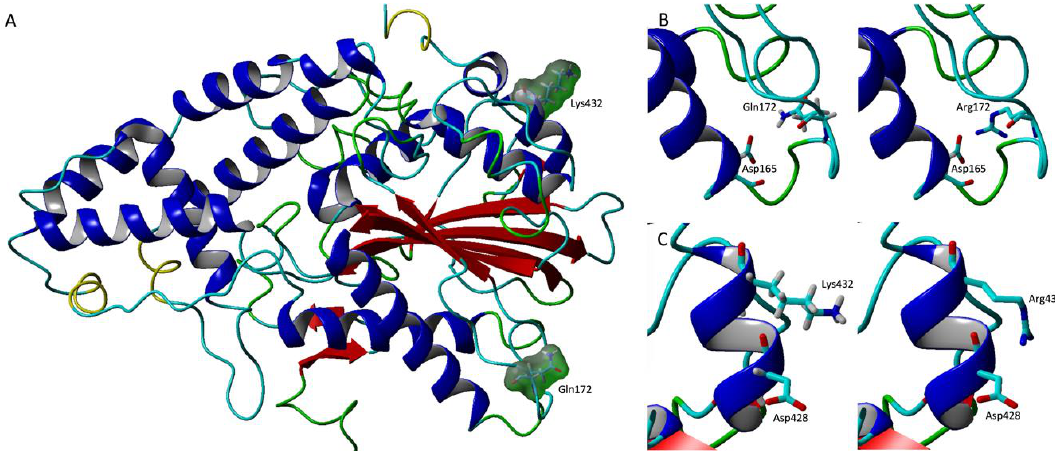
Figure 5. Site-directed mutagenesis on Aspergillus niger N25 phytase. ( A ) Mutation sites of Q172 and K432. ( B ) Substitution of Q172R formed a salt bridge between R172 and D165. ( C ) Substitution of K432R introduced a salt bridge and a new hydrogen bond with D428.